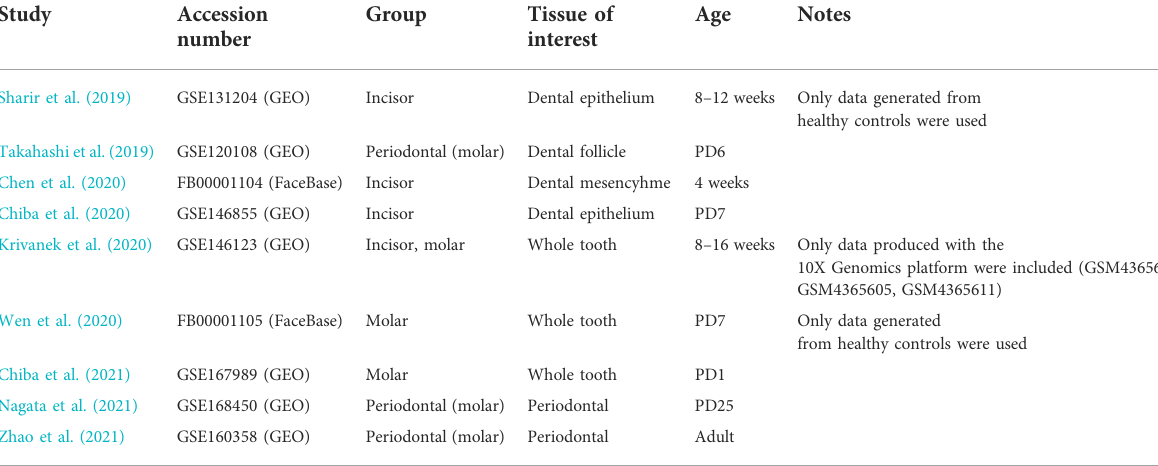
TABLE 1 Publicly available mouse scRNA-seq datasets re-analyzed and integrated toward the comprehensive mouse tooth